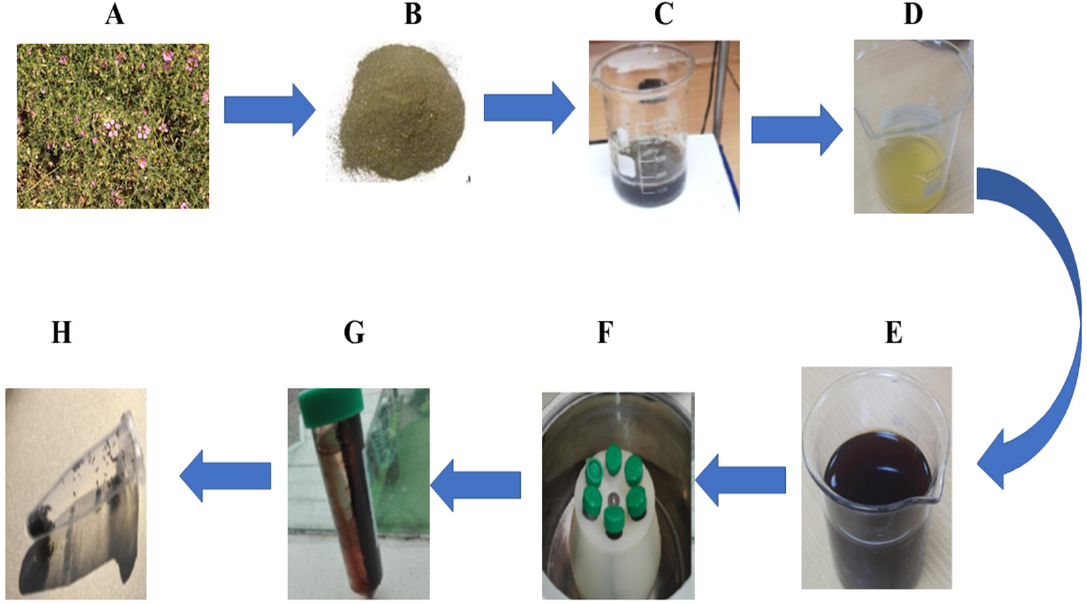
Figure 1. The entire process of making MnO 2 NPs is depicted in this schematic picture. ( A ) Fagonia cretica plant, (B ) Fagonia cretica powder, ( C ) Fagonia cretica extract, ( D ) filtrate, ( E ) reduction and capping of MnO ions by Fagonia cretica extract, ( F ) centrifugations, ( G ) pellets of NPs, and ( H ) puri- fied MnO 2